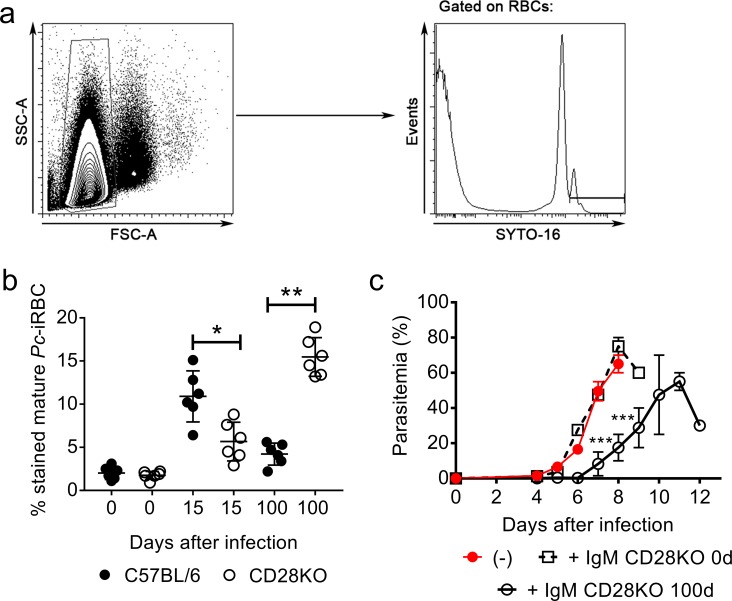
Mature Pc-iRBC recognition and in vivo parasite control by IgM that was produced by infected C57BL/6 and CD28KO mice.(a-c) IgM was purified from serum samples of mice on days 15 and 100 p.i. and from age-matched controls (0d). (a) Representative histogram obtained by flow cytometry showing gating of mature Pc-iRBCs (SYTO 16high RBCs) from RAGKO mice. (b) Percentages of IgM+ mature Pc-iRBCs are shown. (c) Parasitemia curves in RAGKO mice that were previously i.v. treated with purified IgM and then i.p. infected with 1 x 106
Pc-iRBCs. In b-c, Significant differences (*p<0.05, **p<0.01, ***p<0.001) are shown. In b-c, data from three independent experiments (n = 6–7, mean ± SEM) is shown.